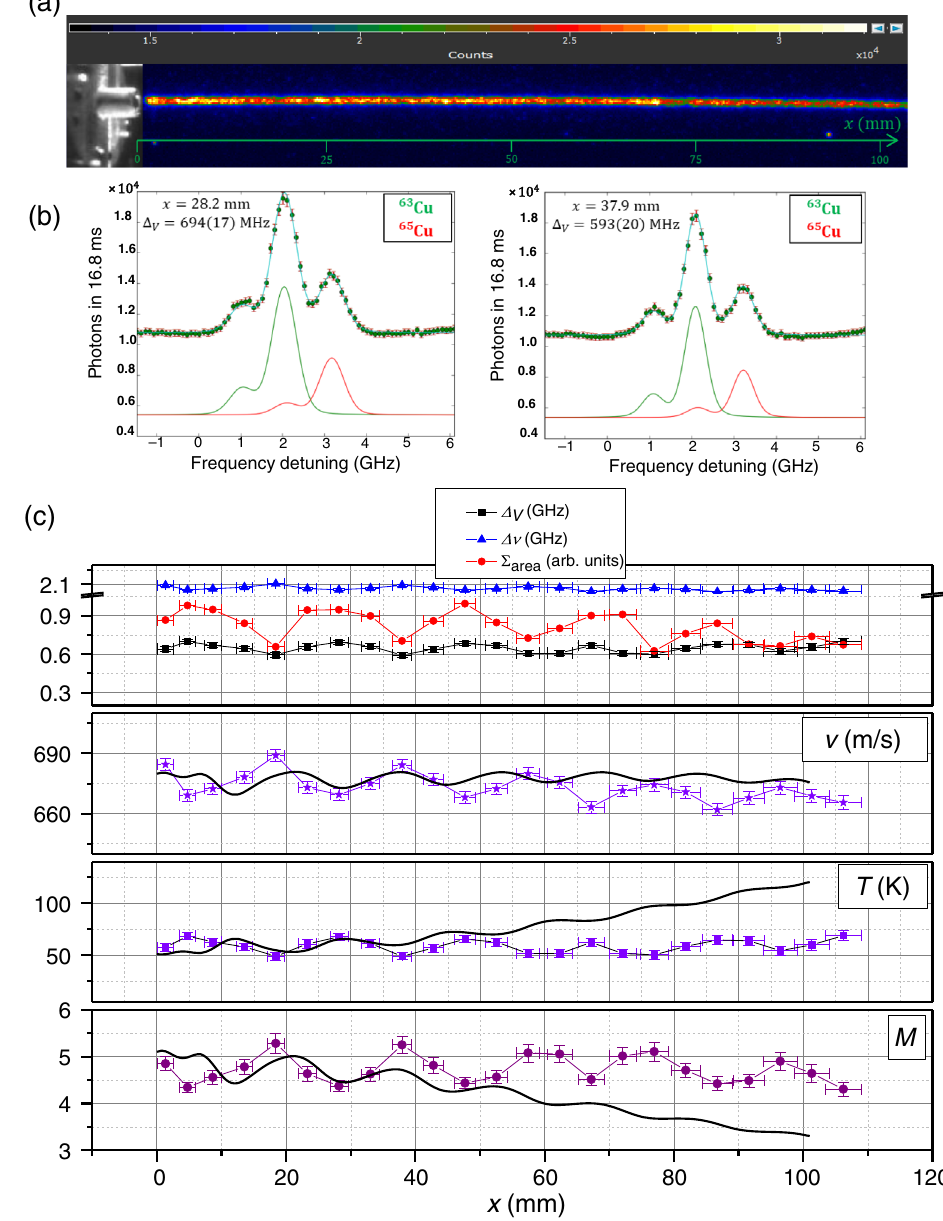
¼ 1 . 46 mbar. (a) The central . P 0 ¼ 379 mbar, P bg bg , velocity v , temperature T , and Mach number M area